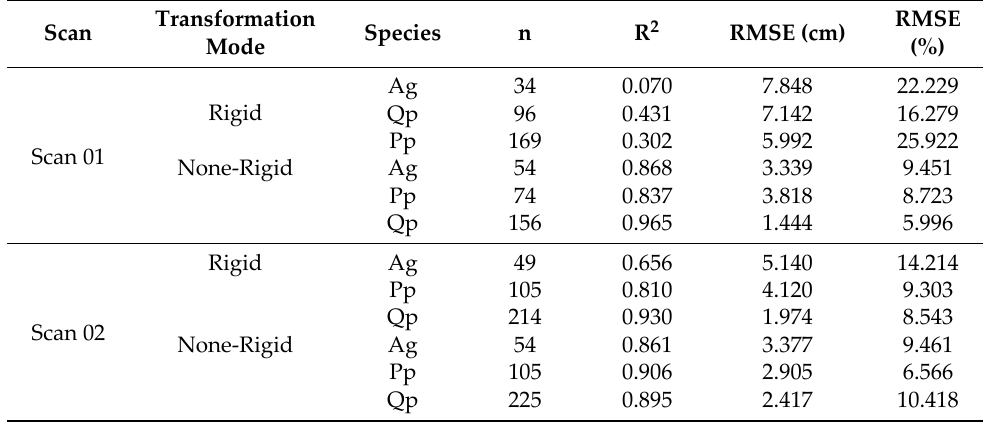
Figure 8. Assessment of tree detection accuracy using the 16 sections (subplots) conforming the 1 ha marteloscope. Control factors presented are mean diameter at breast height in the section (DBH), mean tree height and stem density. The number of trees detected (white background) and the per‑ centage over the number of existing reference trees in the section (shaded background) are presented for the two scans (Scan 01 and Scan 02) and the two‑point cloud transformation modes tested (rigid and none‑rigid). Intervals of 25th percentiles were used for the legend to rank section values of tree density (one, two, three and four bars for each quarter), DBH (white, green, yellow and red from low to high density) and tree height (red down, yellow pointing down, yellow pointing up, and green up for lower to taller trees) over the array of 16 section values for the marteloscope. Table 5. Summary statistics for the estimation of DBH using matching tree pairs using linear re‑ gression. Detected DBH estimates were used to estimate DBH measurements. Fitting statistics and number of observations (n) are presented for each species ( Alnus glutinosa (Ag), Pinus pinaster (Pp) and Quercus pyrenaica (Qp)), scan transformation mode and for the tested scanning paths (Scan 01 and Scan